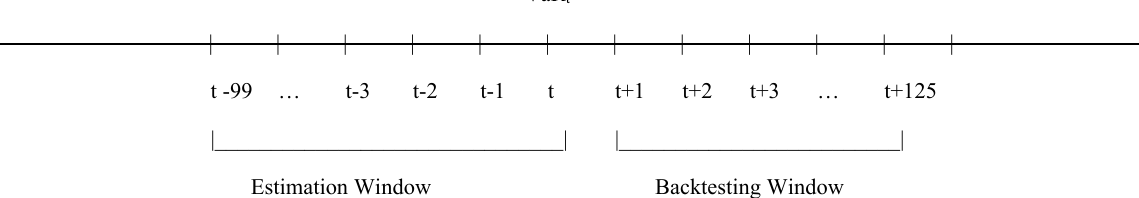
Figure 2. Estimation and backtesting windows. This figure shows the estimation and the backtesting windows. VaR on day t is estimated using the past 100 days of data for Model 1 (using historical simulation), Model 2 (assuming normality of raw returns), and Model 3 (after transforming raw data). Then the exceptions test is carried out for a window of 125 days following the VaR estimate at date t. Both windows are rolled forward by one day and the procedure repeated for both models until the sample period is exhausted. This leads to testing of exceedances of VaR limits over 47,000 data points.